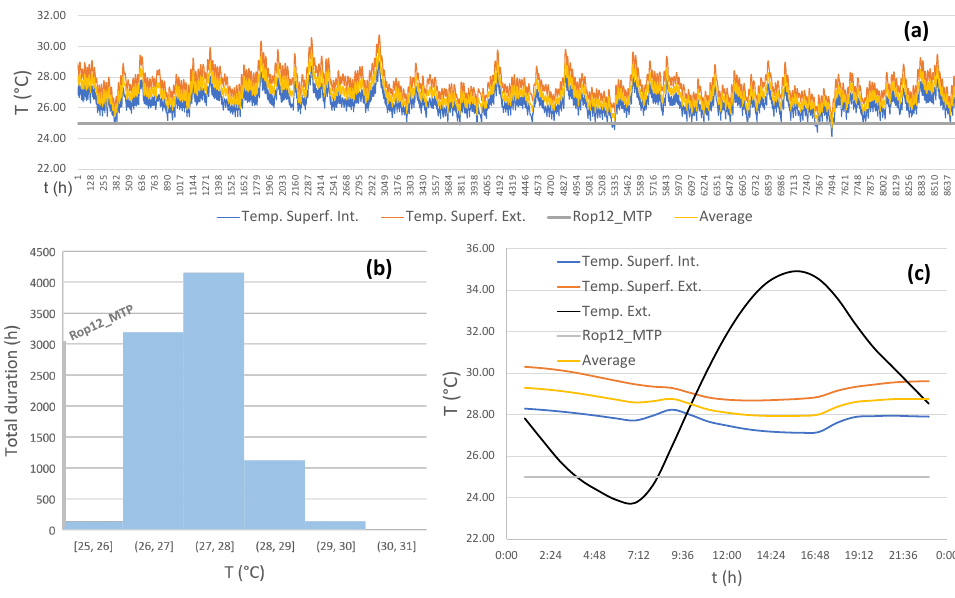
Figure 13. Local results from simulations for H200: ( a ) hourly temperatures for the entire year, ( b ) duration-based frequency for average temperature, and ( c ) hourly temperatures on 18